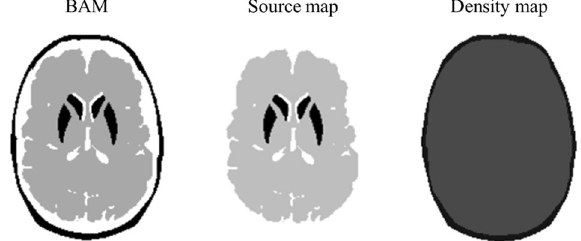
Figure 3. The source and density maps were created from BAM. The source map involved both background and striatal regions. The ratio of the striatal to background region accumulation was set to rates of 8:1, 6:1, and 4:1. The density map consisted of two parts only—bone and non-bone—and each density was 1.22 g/cm3 and 1.04 g/cm3, respectively.